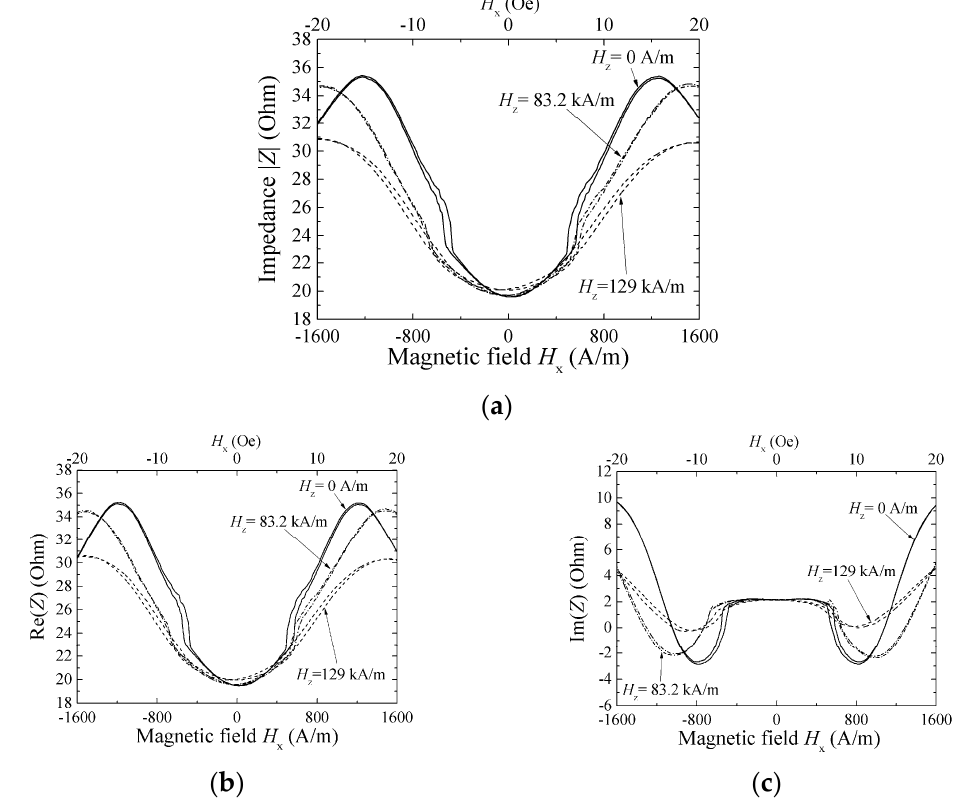
Figure 12. Variation of sensor impedance as a function of external field in X direction. Element dimensions, length: 1000 μ m, width: 50 μ m. Measurement frequency: 800 MHz. ( a )|Z|, ( b ) Re(Z), and ( c ) Im(Z) [21].